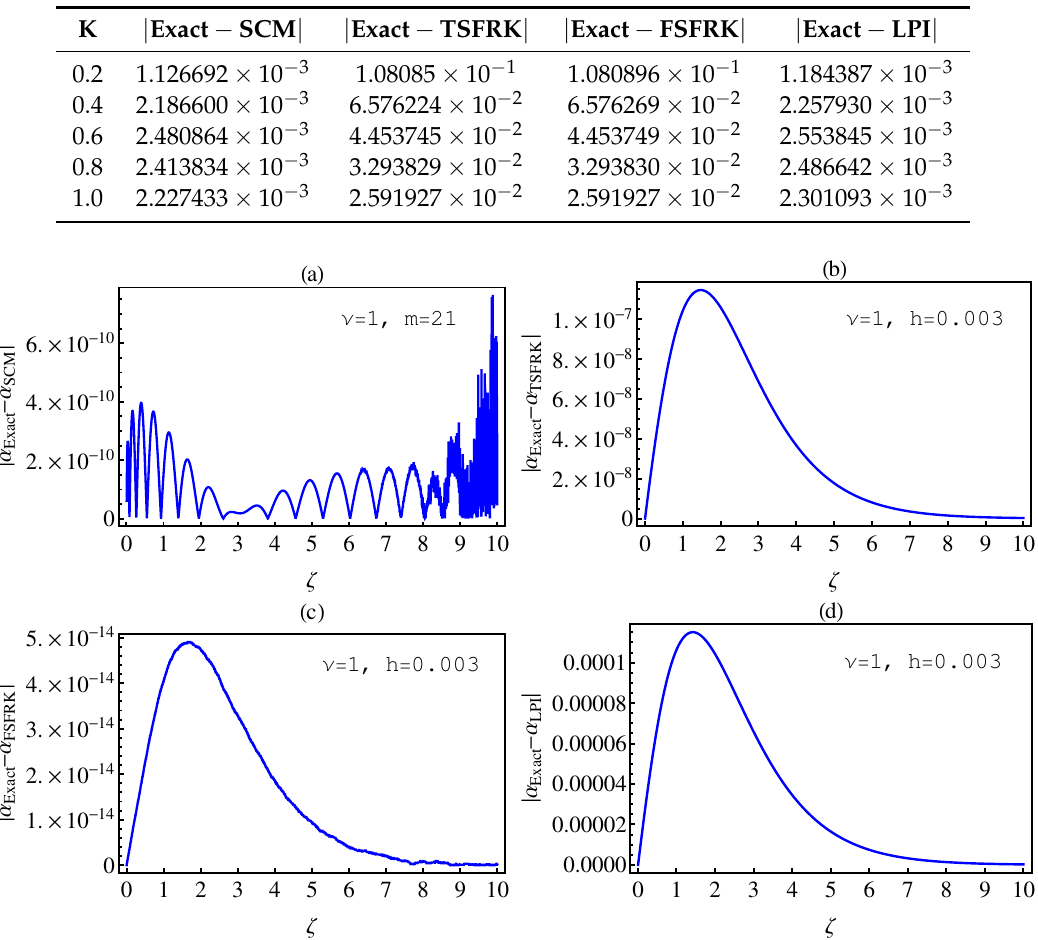
Table 2. The absolute error between the exact solution (6) and the numerical solutions by SCM, TSFR, FSFRK, and LPI, respectively, for ν = 0.8, ζ = 5, h = 0.003, m = 21 with different values of K .